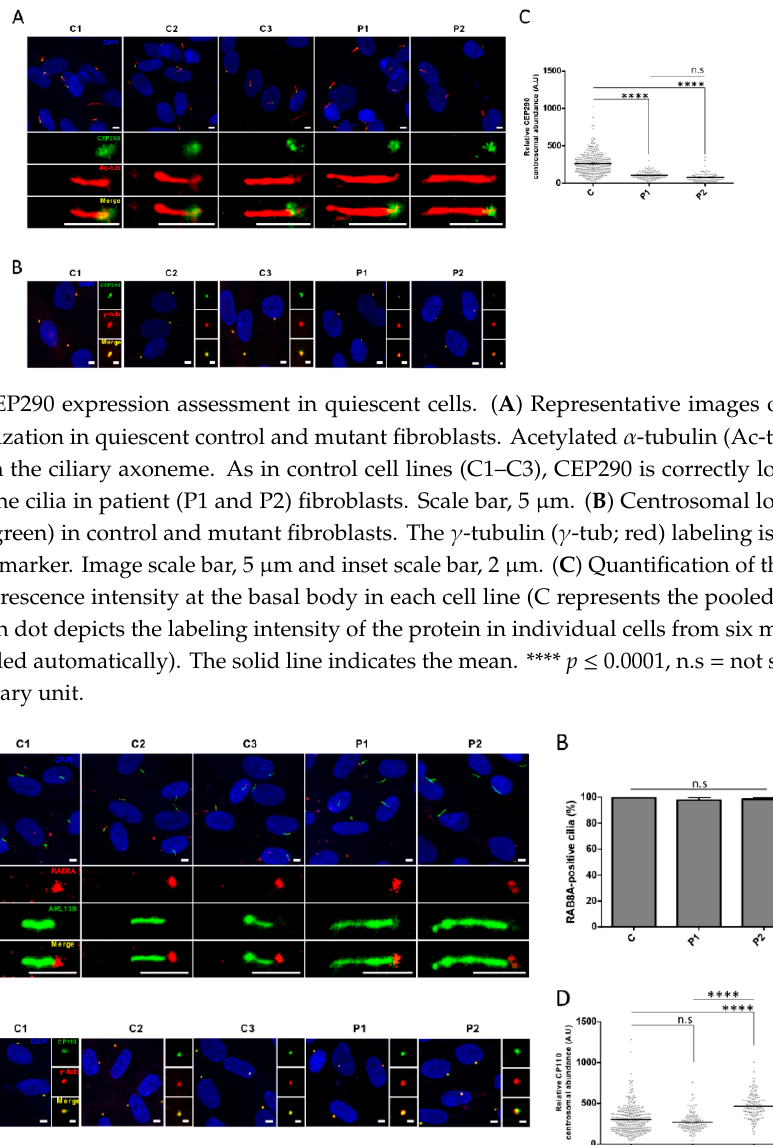
Figure 3. CEP290 expression assessment in quiescent cells. ( A ) Representative images of CEP290 Figure 2. Effect of the natural exclusion of PTC-encoding exon 36 on CEP290 protein production. ( A ) (green) localization in quiescent control and mutant fibroblasts. Acetylated α -tubulin (Ac-tub; red) is Immune detection of the CEP290 and β -Actin in control cell lines (C1–C3) and mutant fibroblasts (P1 used to stain the ciliary axoneme. As in control cell lines (C1–C3), CEP290 is correctly localized at the and P2). ( B ) Quantification of CEP290 abundance relative to β -Actin in control (C represents the base of the cilia in patient (P1 and P2) fibroblasts. Scale bar, 5 µm. ( B ) Centrosomal localization of cilia abundance was in the normal range and reduced in P1 and P2 fibroblasts, respectively ( p ≤ 0.001; pooled values of C1–C3) and patient fibroblasts. Bars correspond to the mean value ± SEM from four CEP290 (green) in control and mutant fibroblasts. The γ -tubulin ( γ -tub; red) labeling is used as a independent experiments. ** p ≤ 0.01, n.s = not significant. centrosomal marker. Image scale bar, 5 µm and inset scale bar, 2 µm. ( C ) Quantification of the CEP290 immunofluorescence intensity at the basal body in each cell line (C represents the pooled values of C1–C3). Each dot depicts the labeling intensity of the protein in individual cells from six microscope fields (recorded automatically). The solid line indicates the mean. **** p ≤ 0.0001, n.s = not significant. A.U. = arbitrary unit.